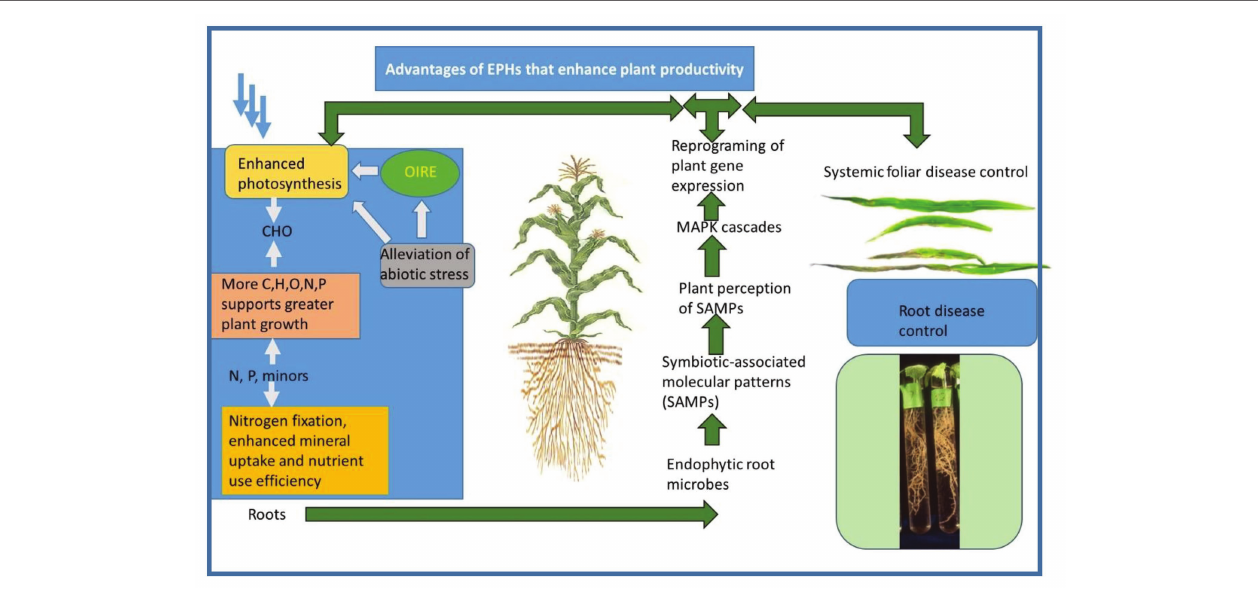
FIGURE 2 | A synoptic diagram of the interactions of plants and endophytes that result in the formation of EPHs. A similar diagram was presented in (Harman and Uphoff, 2019), which is an open access journal. The photograph of corn leaves is from (Harman et al., 2004a) and is used with permission of the